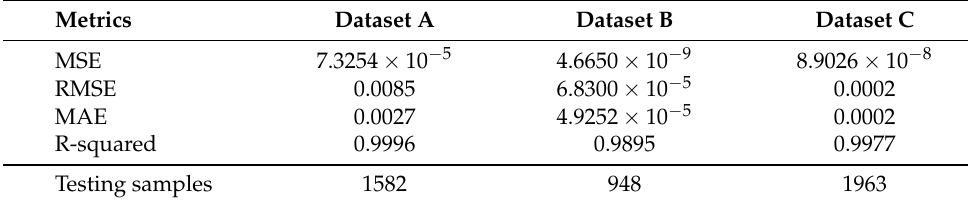
Table 6. Performance results of supercapacitor datasets: testing phase.